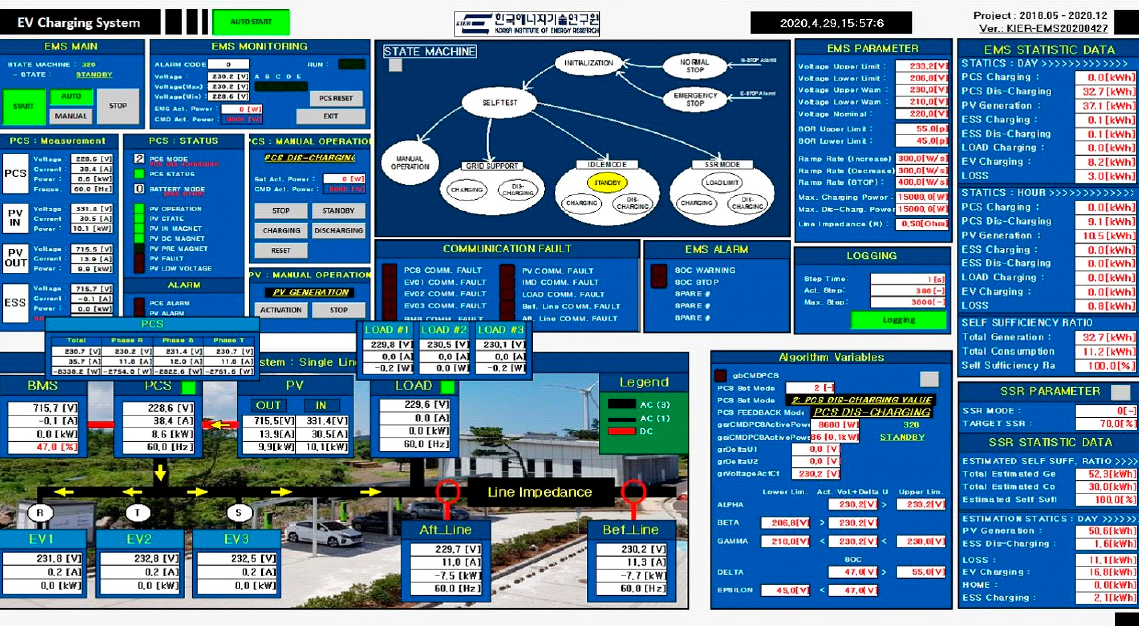
Figure 8. EMS for EV Charging Infrastructure.